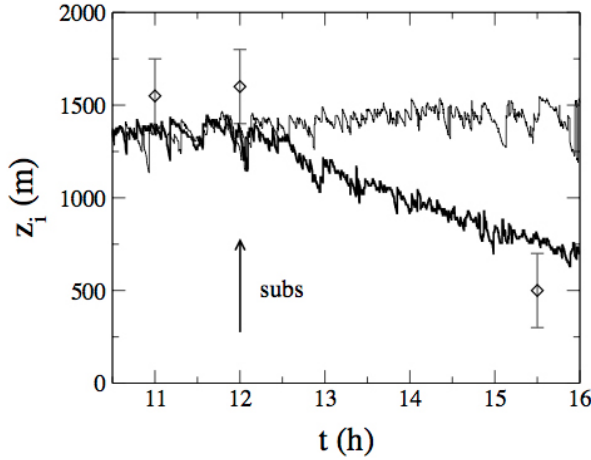
Fig. 6. Temporal behavior of the boundary layer height from LES simulations with and without subsidence, for the simulated day 16 June 1992. The points with error bars are the experimental es- timates from the radiosoundings. The arrow marks the initial time when subsidence is inserted into the LES runs.